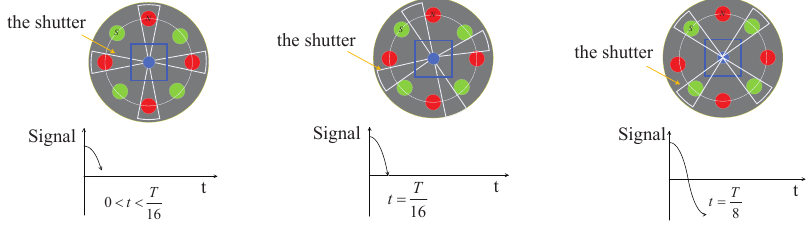
Figure 1. Block diagram of the rotating shutter antenna when N = 4.